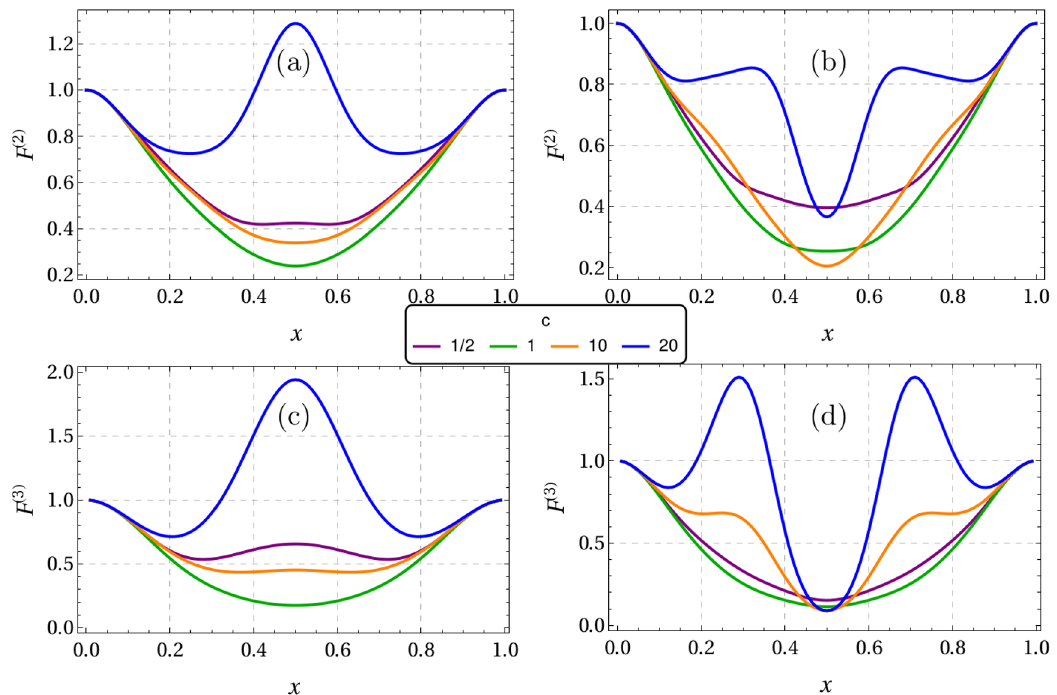
Figure 3 . The correlator F ( n ) for (a) n = 2 , | s i = L 2 | 0 i , (b) n = 2 , | s i = L − 3 L − 2 | 0 i , (c) n = 3 − 2 | s i | s i = L − 2 | 0 i , and (d) n = 3 | s i = L − 3 | 0 i for several values of the central